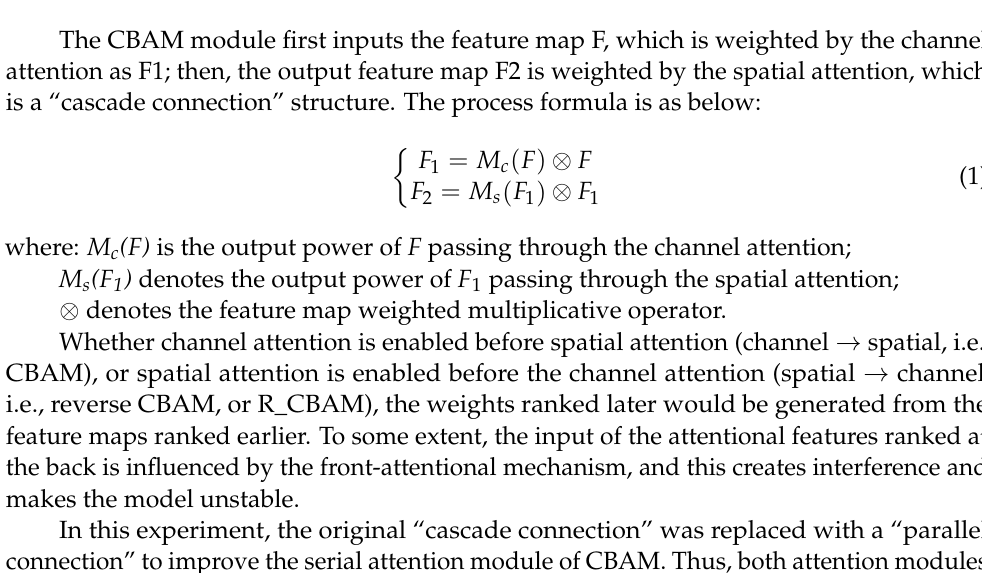
Figure 4. Structure of CBAM.